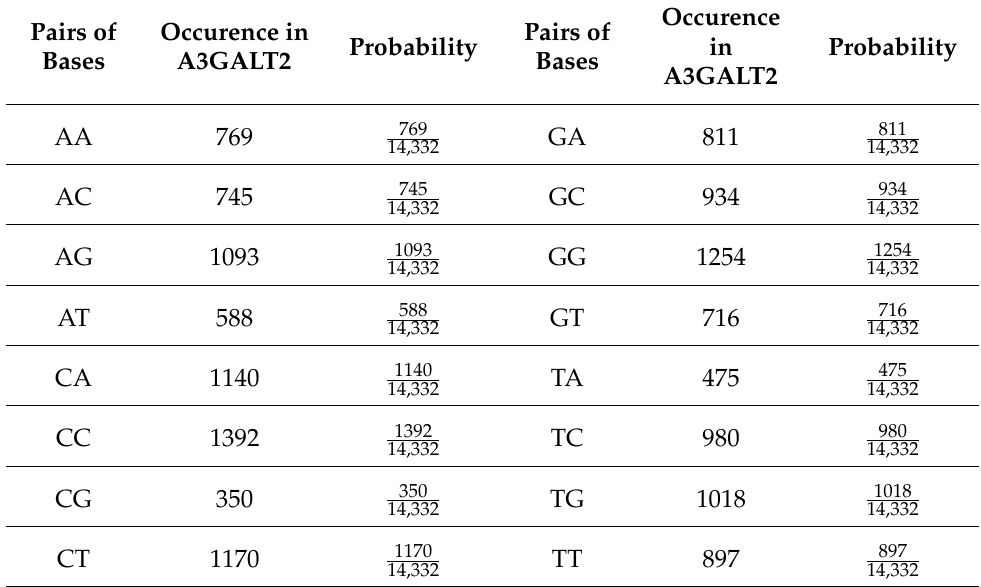
Table 2. Occurence of nucleotide pairs of bases in